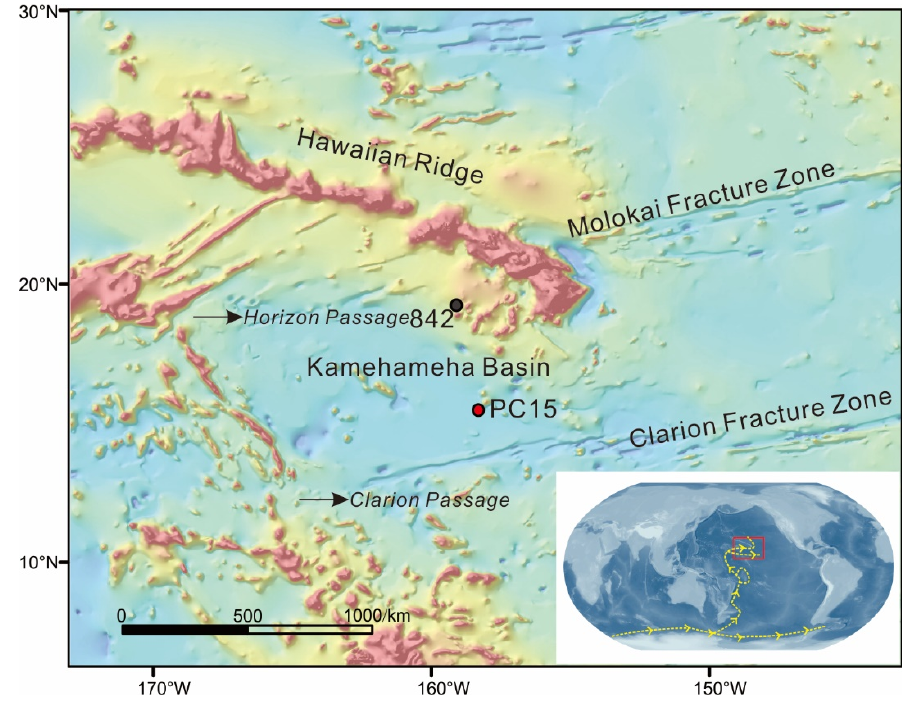
Figure 1. Schematic map of the central Pacific region showing the study sites and other referenced sites. The yellow dashed line in the bottom right insert shows the paths of the Lower Circumpolar deep water (LCDW) and the Antarctic Bottom Water (AABW). The base data are from ref. [14] and generated using the open and free software DIVA–GIS 7.5 (http://www.diva-gis.org/, accessed on 10 September 2021).